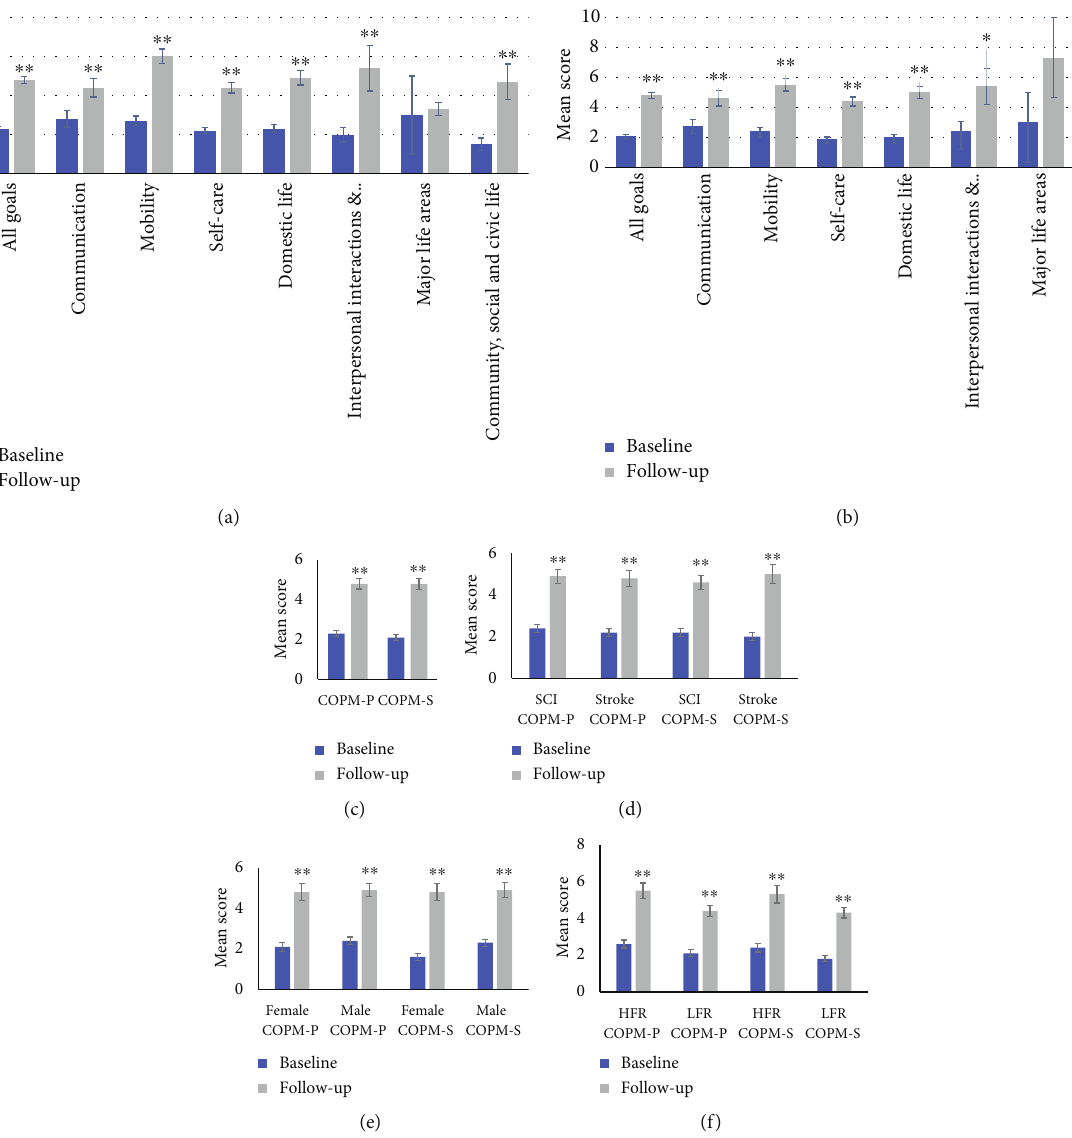
Figure 3: Mean Canadian Occupational Performance Measure scores at baseline and at the 12-month follow-up, presented as mean score, split in (a) all goals and ICF chapters COPM-P, (b) all goals and ICF chapters COPM-S, (c) study group as a whole, (d) diagnosis, (e) sex, and (f) treatment regimen. SCI = spinal cord injuries; HFR = high-functioning regimen; LFR = low-functioning regimen; Interpersonal interactions & … = interpersonal interactions and relationships; COPM-P = Canadian Occupational Performance Measure-Performance; COPM-S = Canadian Occupational Performance Measure-Satisfaction. ∗ indicates signi fi cant di ff erence below 0.005, ∗∗ indicates signi fi cant di ff erence below 0.001, and error bars indicate standard error